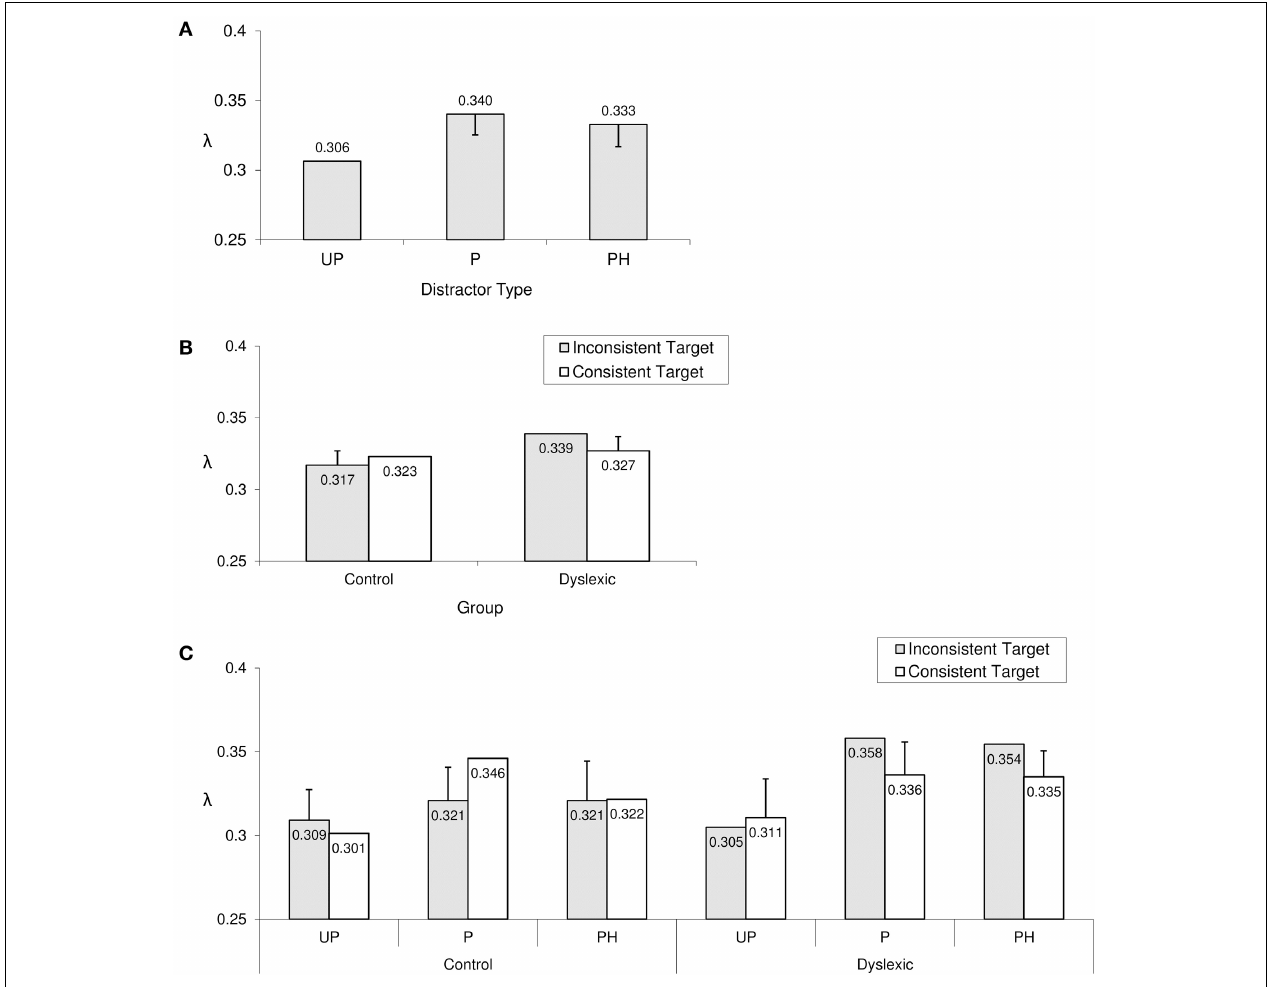
FIGURE 5 | Significant effects in overall error rate ( λ ). (A) The main effect of distractor type; (B) the group × target type interaction; (C) the group × target × distractor interaction. Error bars represent Sidak-adjusted 95% confidence half-widths for (A) contrasts with the UP distractor condition, (B)